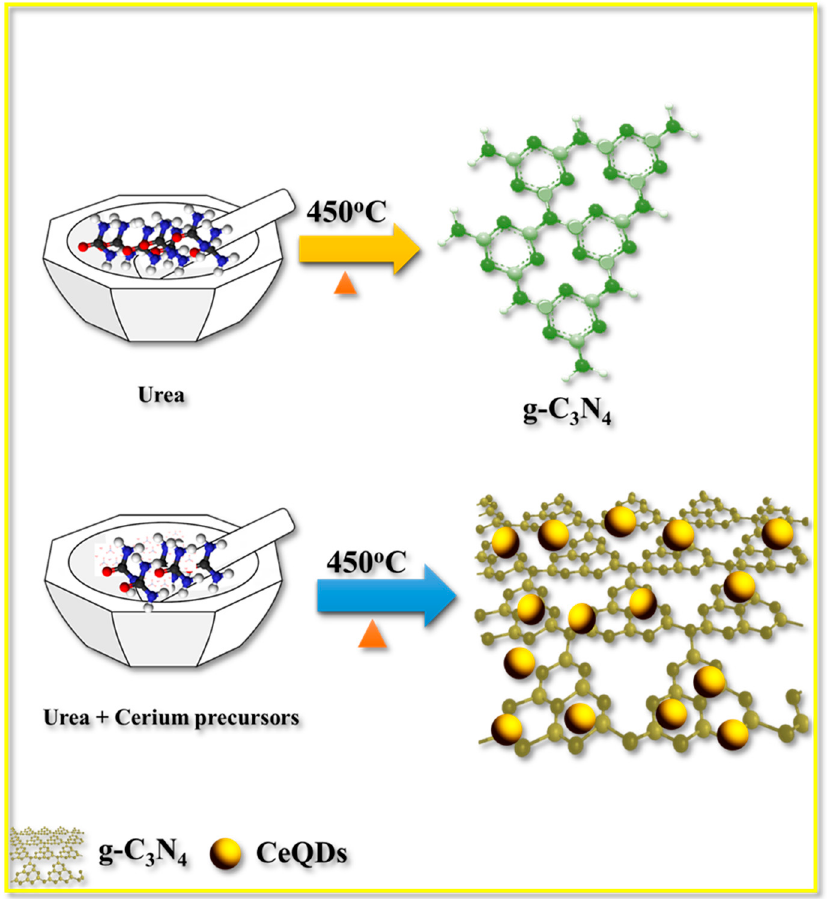
Figure 9. Schematic diagram of the CN and CeQDs/CN nanostructure synthesis process.